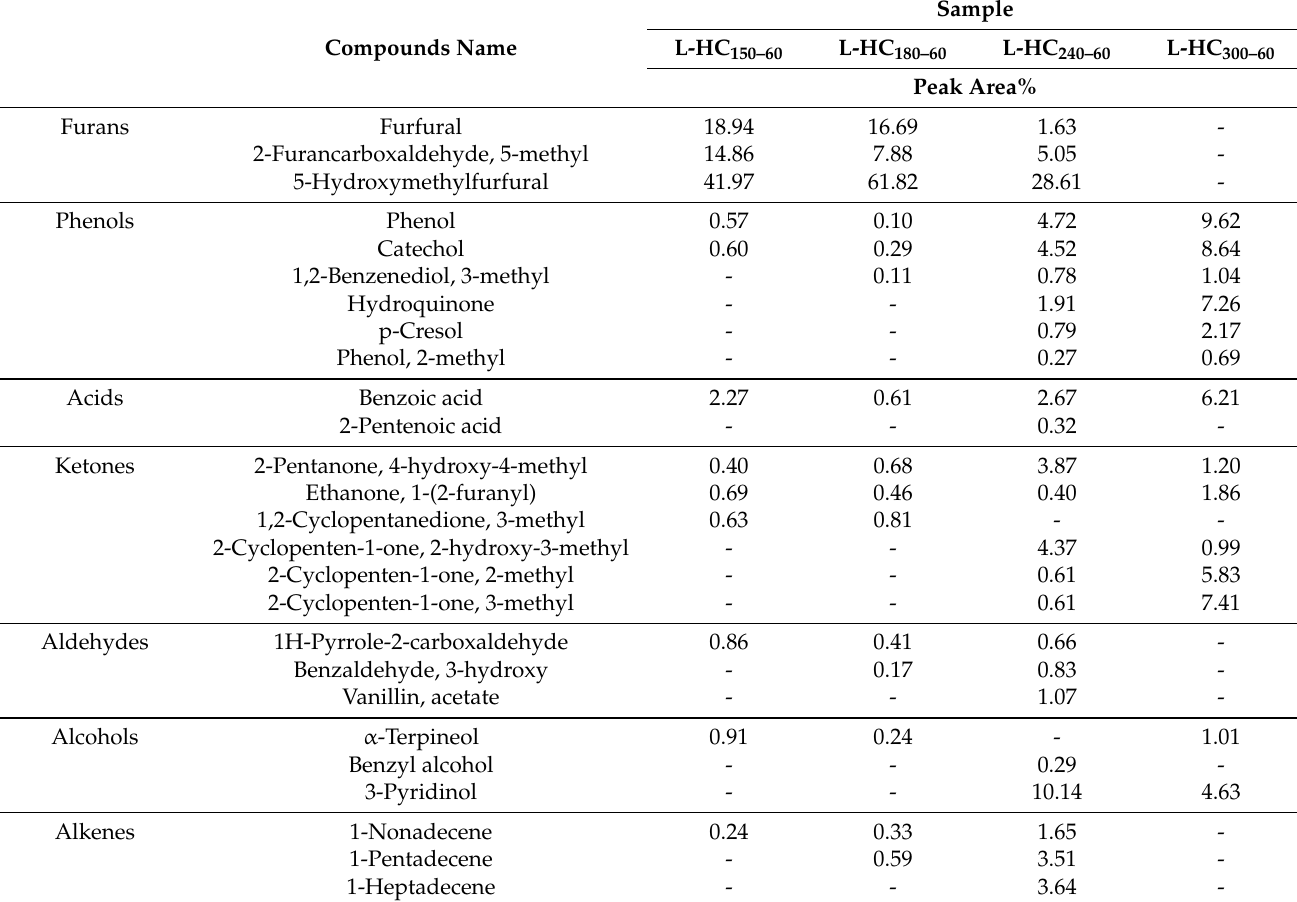
Table 4. Major chemical components of the light bio-oil determined by GC-MS